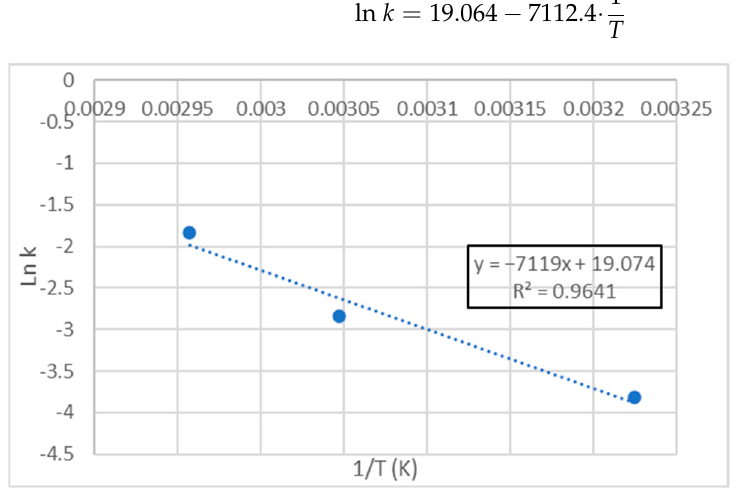
Figure 3. Linear adjustment of Ln k versus 1/T for TBARS in treatment T1.